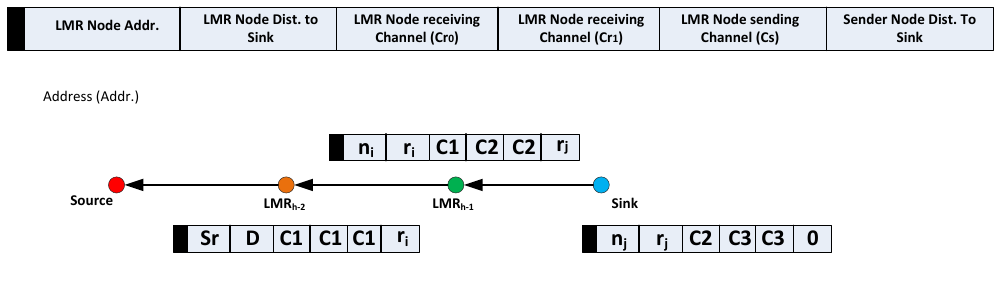
Figure 4. Virtual contention group (VCG) formation operation with payload. LMR, local minimum